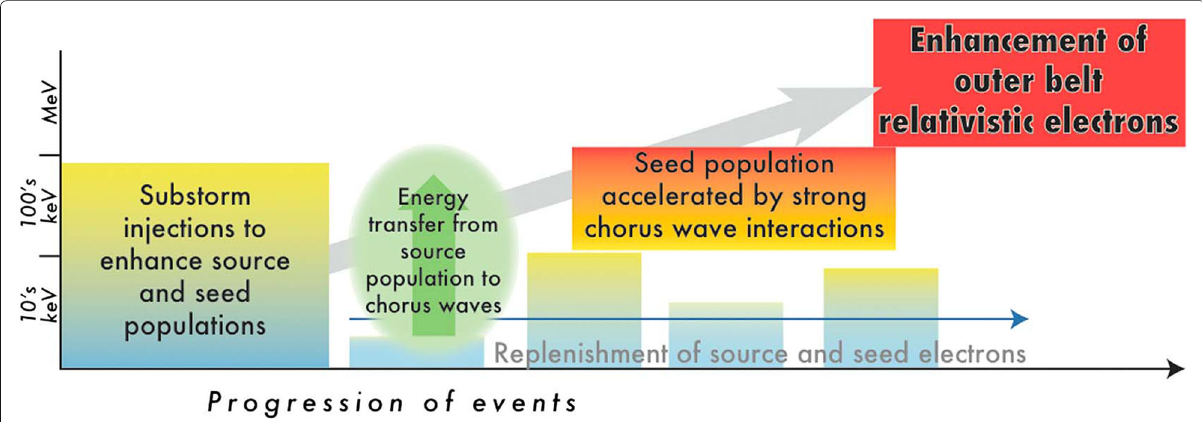
Fig. 11 Diagram illustrating the interplay and contribution of low-energy electrons (source) in generating plasma waves which act upon a seed population to energize electrons to relativistic energies (reproduced from Jaynes et al.